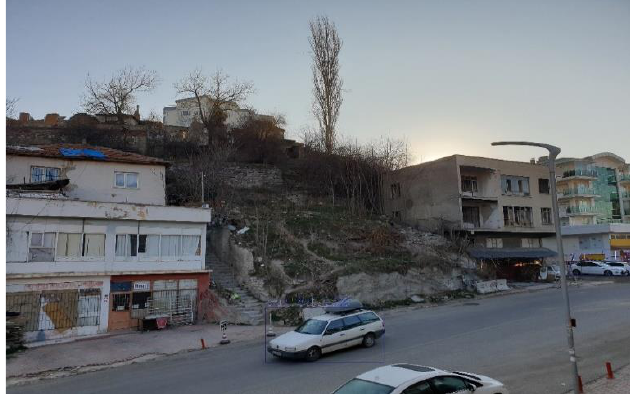
Fig. 19. Objects recognized with RetinaNet architecture on the street.